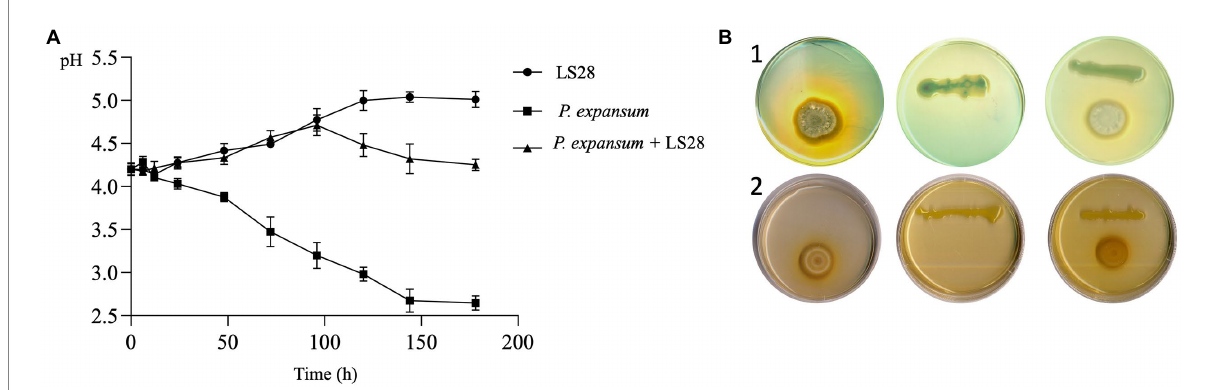
FIGURE 4 (A) In vitro extracellular pH trend of P. expansum co-inoculated with LS28 in liquid AMM. pH was measured at 0, 6, 12, 24, 48, 72, 96, 120, 144, and 178 h after co-inoculation. Data shown are the mean values ± SD from three independent experiments. (B) Representative pictures showing P. terrestris strain LS28 and P. expansum strain 7015 grown alone or in dual cocultures for 7 days in AMM plates containing the pH indicators bromocresol green (yellow, pH < 3.8; blue, pH > 5.4) or purple (yellow, pH < 5.2; purple, pH > 6.8). In the plates amended with the pH indicator bromocresol green (b-1), the extracellular acidification produced by P. expansum growth is visible as a clear halo, while this pH changing is counteracted by the biocontrol yeast; No color changes occur in the plates with the pH indicator bromocresol purple